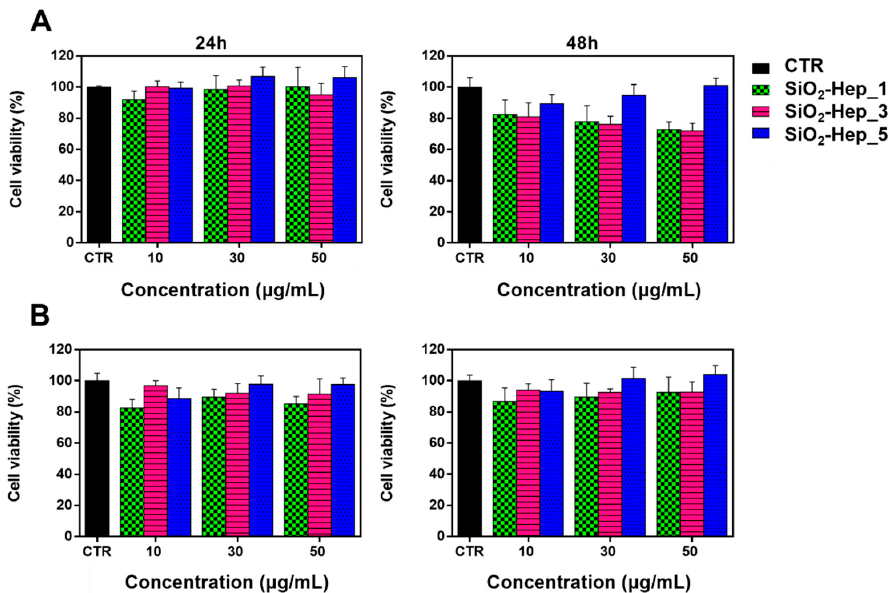
Figure 9. Cell Viability percentage of ( A ) HDF and ( B ) HS578T cells lines after 24 and 48 h of incubations with SiO 2 -Hep_1, SiO 2 -Hep_3, and SiO 2 -Hep_5 NPs, at concentration of 10, 30, and 50 μ g.